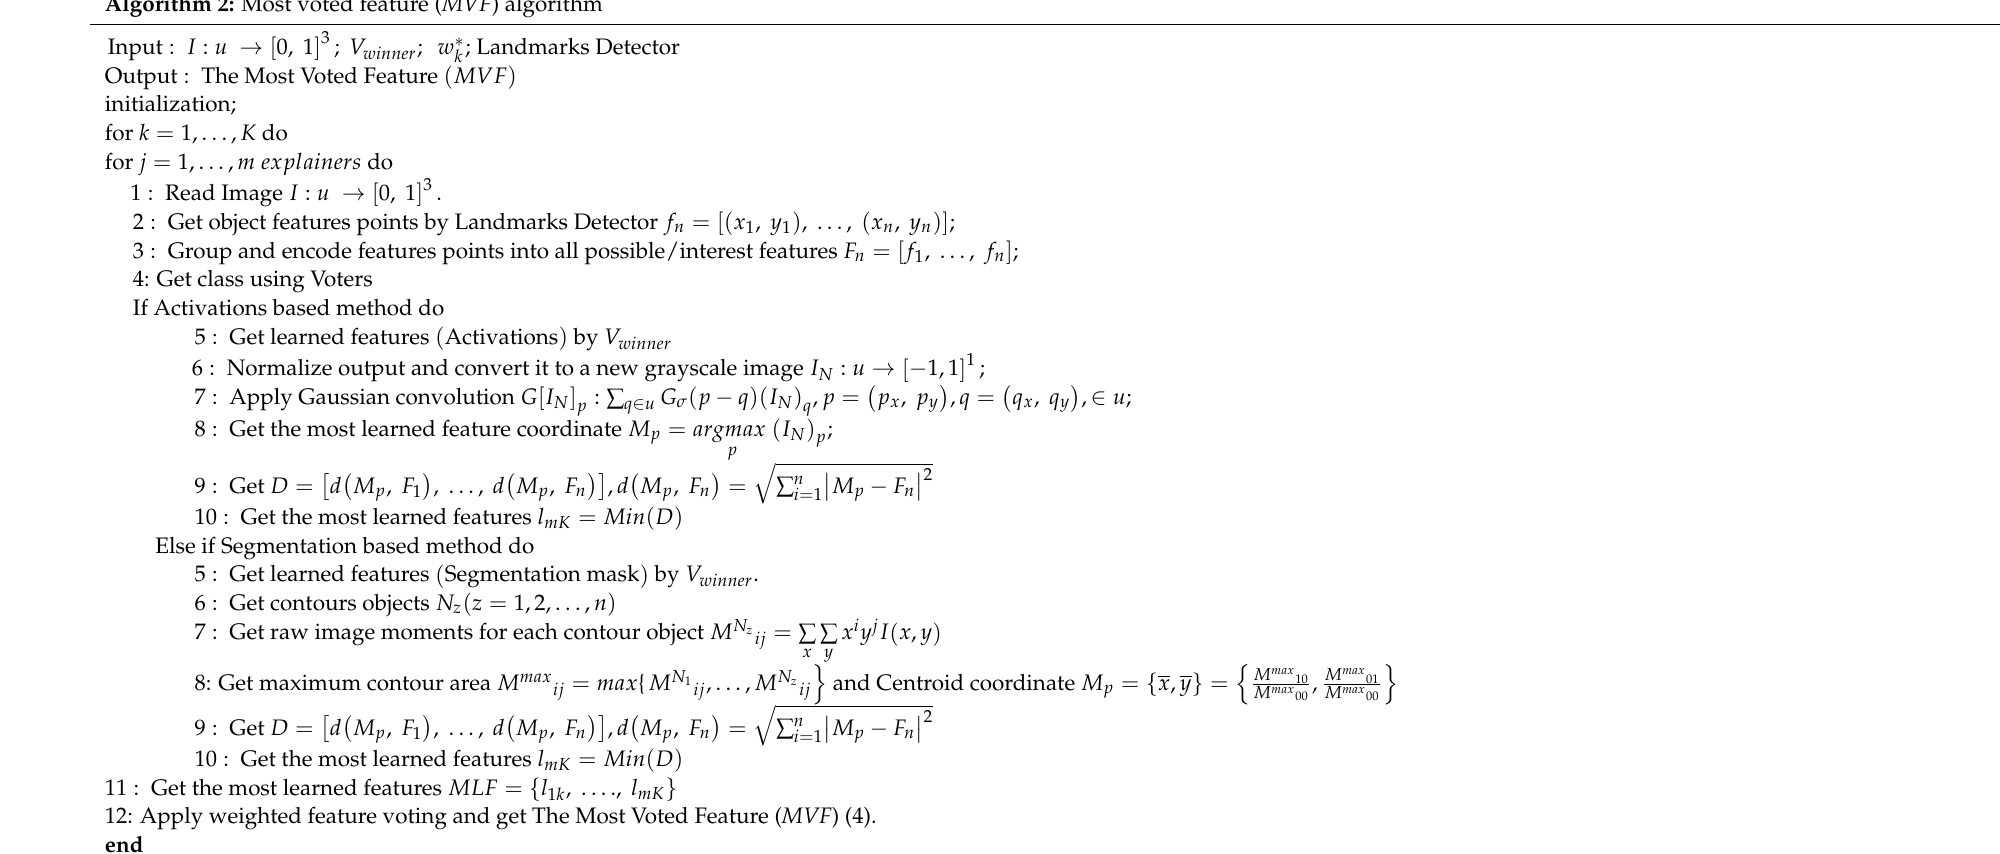
Algorithm 2: Most voted feature ( MVF )